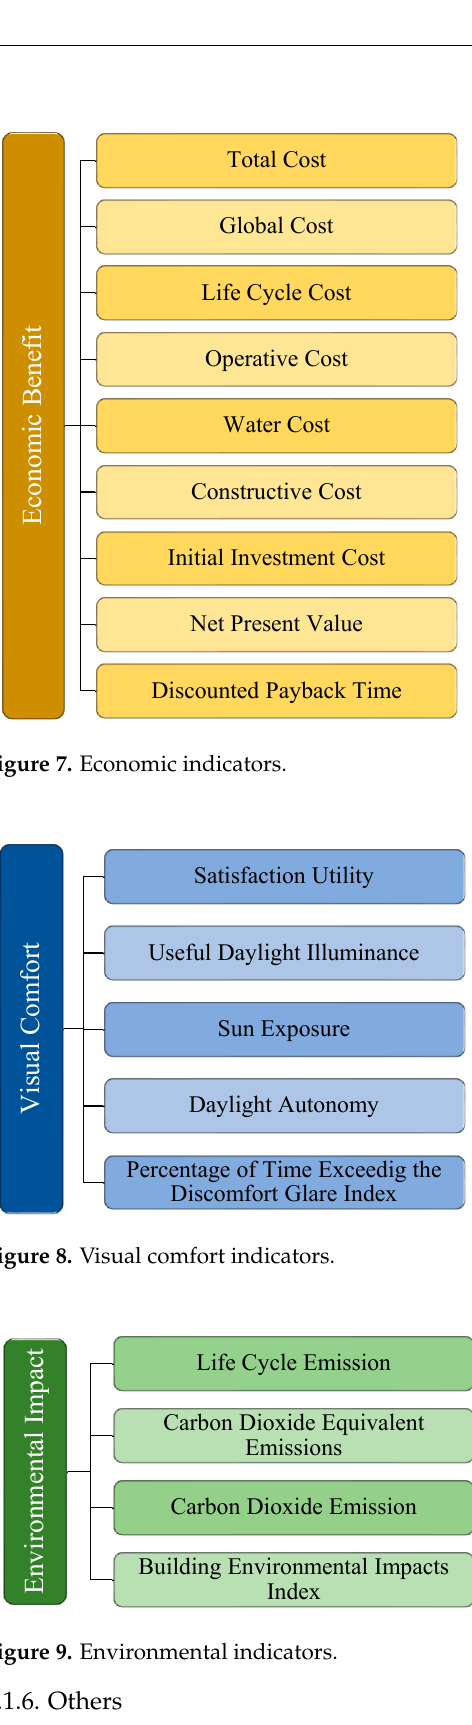
11 of 28 Figure 6. Thermal comfort indicators. 4.1.3. Economic Benefit